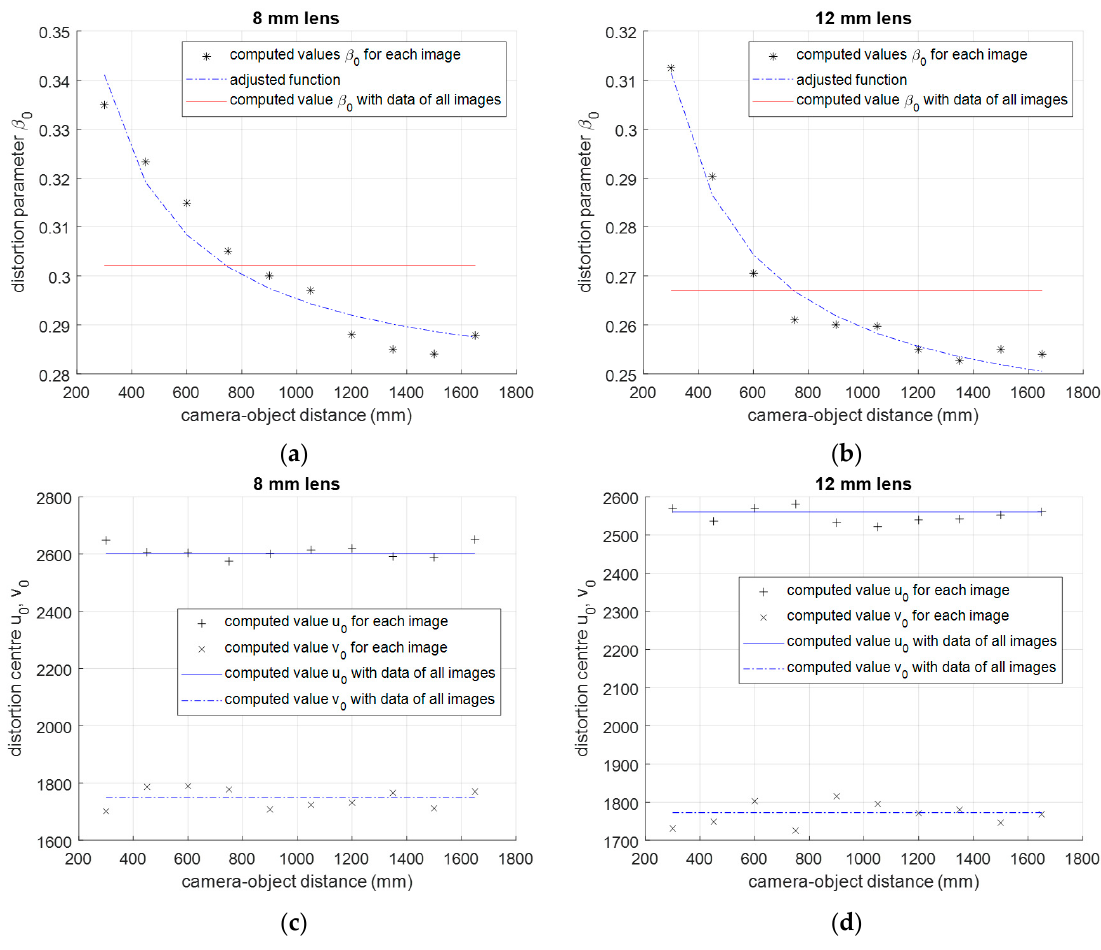
Figure 7. Variation of first-order lens distortion model parameters with the camera-object distance. ( a , b ) Computed parameter β 0 for 8 mm and 12 mm lens respectively. The asterisks show the computed value of parameter β 0 for each image and the dashed line shows the value given by the function β 0 ( d ) adjusted using the least squares technique with asterisk data β 0i . ( c , d ) Distortion center u 0 , v 0 for 8 mm and 12 mm lens respectively.